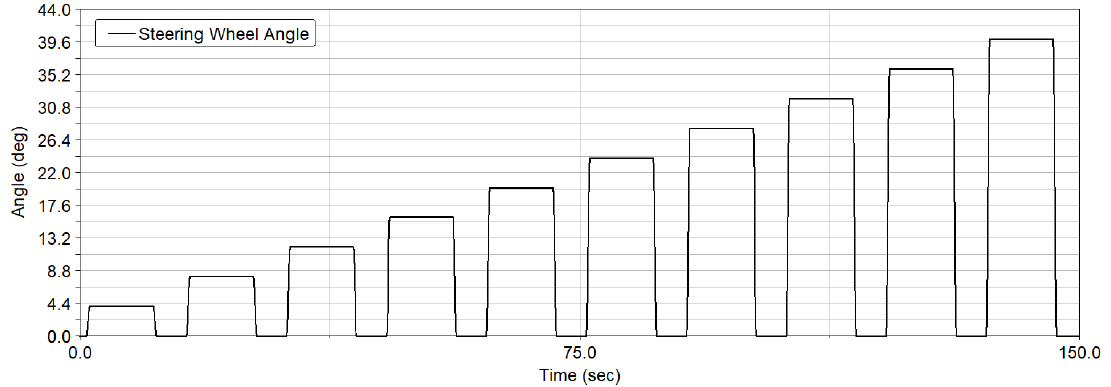
Figure 3 . Skid-pad virtual test via successive step-steer maneuvers, driver input . Figure 3. Skid-pad virtual test via successive step-steer maneuvers, driver input.